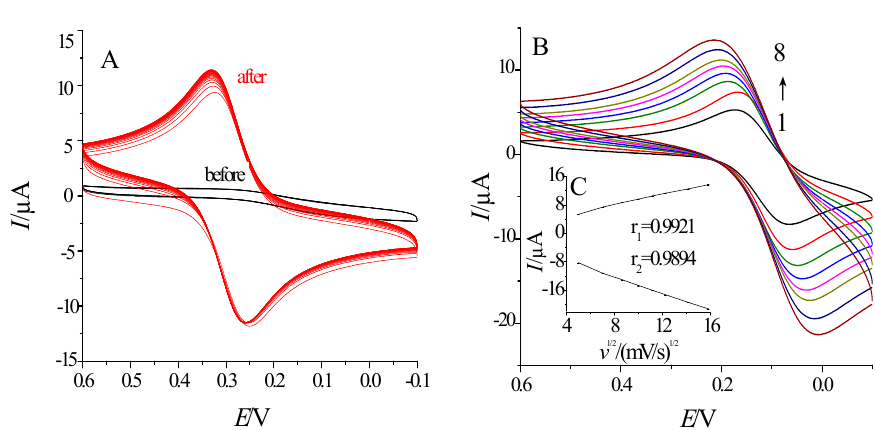
Figure 2. Characterization of the effect of the GCE pretreatment: ( A ) Cyclic Voltammetry; ( B ) Cyclic voltammograms of bare GCE at scan rates of 0.025, 0.050, 0.075, 0.100, 0.125, 0.150, 0.200, 0.250 V/s (1 → 8); the inset shows the dependence of the redox peak currents on the square root of scan rates.